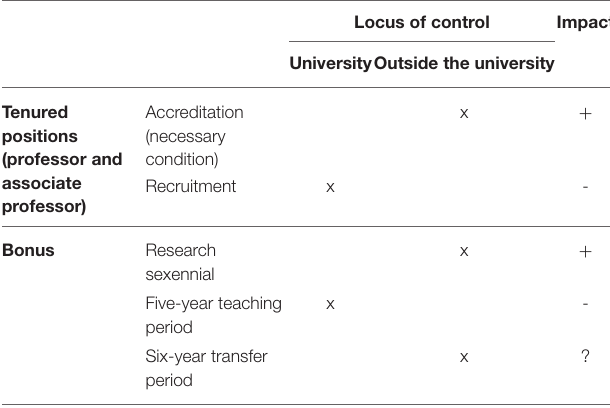
TABLE 9 | Impact of the university career and salary